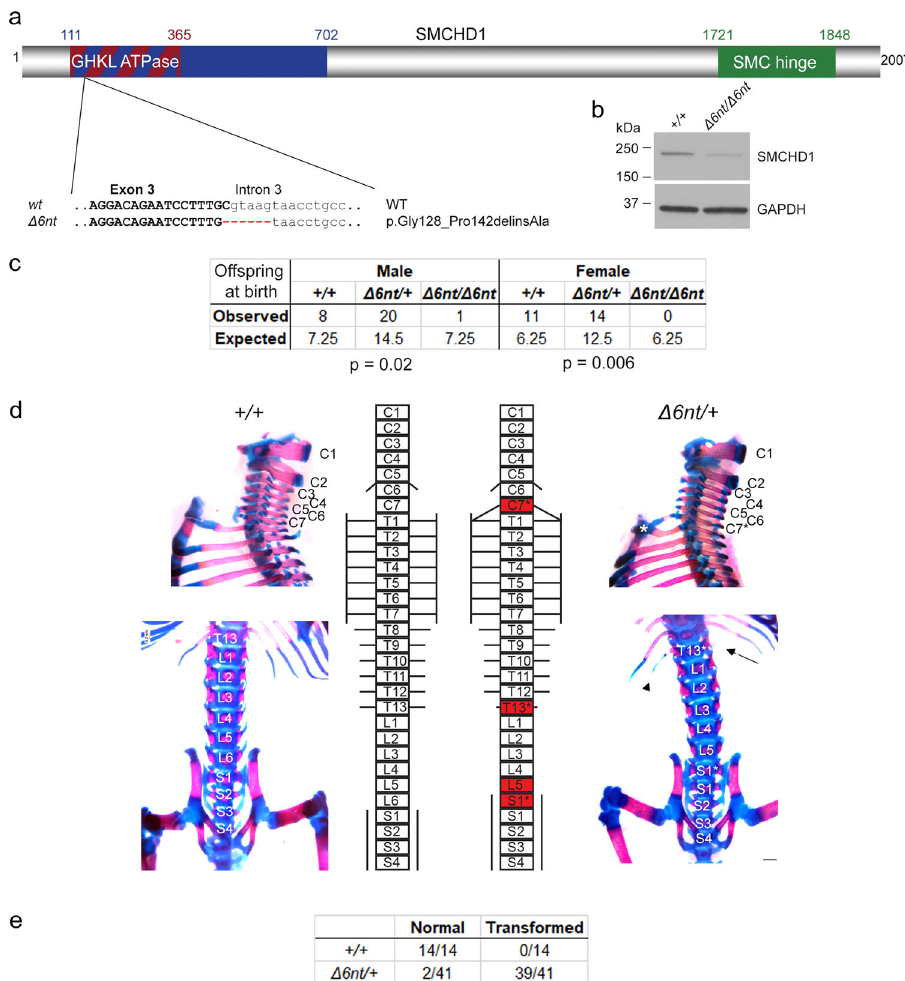
Fig. 4 Smchd1 haploinsuf fi ciency in mouse also causes homeotic transformations. a A new Smchd1 loss-of-function allele was generated using CRISPR/ Cas9. This produced a 6 nt deletion including the splice donor site of intron 3. This resulted in a number of aberrantly spliced transcripts. The protein variation listed is the smallest in-frame mutation detected, a 14 amino-acid deletion including the catalytic residue of the GHKL ATPase domain p.E147. b Western blot from heads of E10.5 embryos show a markedly reduced level of SMCHD1 protein in the Δ 6nt/ Δ 6nt , which runs slightly faster than wildtype SMCHD1. n = at least 5 embryos per genotype. c Observed and expected numbers of pups born of each genotype. Axial skeletal patterning analysis of + / + and Δ 6nt/ + animals. Homeotic transformations observed in the animals are marked in red in the schematic ( d ). Transformations include C7 → T1, T13 → L1 and L6 → S1. C7 rib is labelled with a *, the missing T13 rib is marked with an arrow and the hypomorphic T13 rib is labelled with an arrowhead. Number of animals analysed with each phenotype are in ( e ). Animals showing any of the homeotic transformations are considered as transformed. Most Δ 6nt/ + animals show all of the homeotic transformations marked in ( d ). Scale bar = 500 µ